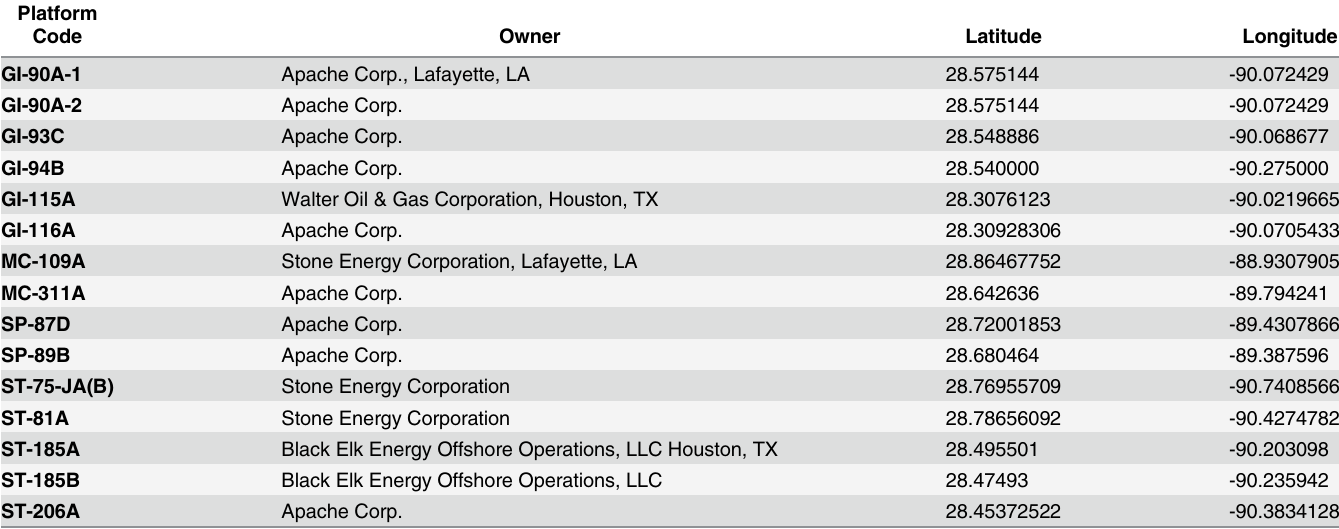
Table 1. A list of all platforms surveyed by ROV during this study. Platform